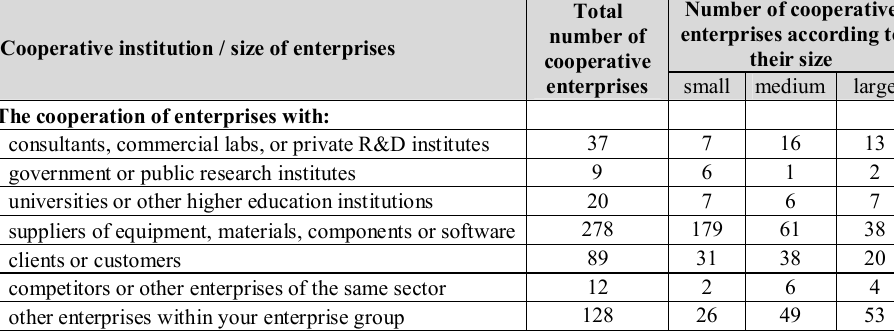
Number of cooperative Total enterprises according to number of their size cooperative enterprises small medium large